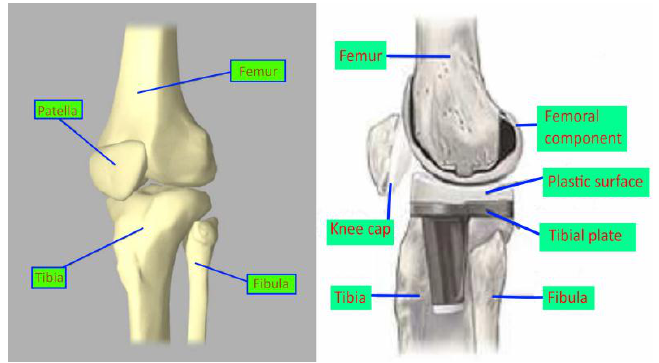
Figure 1. Bones around the knee joint and position of knee replacement after the knee arthroplasty.